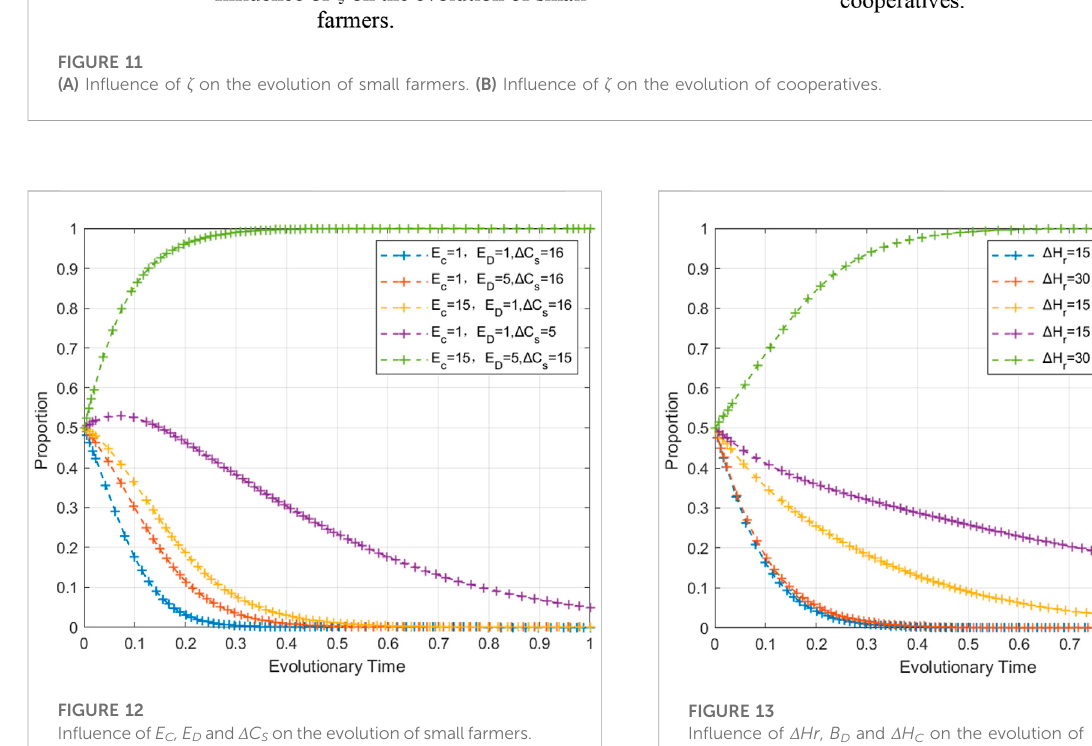
FIGURE 12 In fl uence of E C , E D and Δ C S on theevolution of smallfarmers.